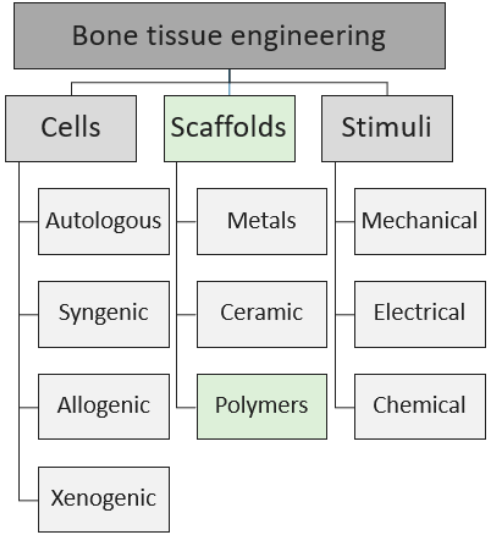
Figure 1. Schematic representation of the main components of the bone tissue engineering. In this review we will focus on the natural and synthetic polymeric sca ff